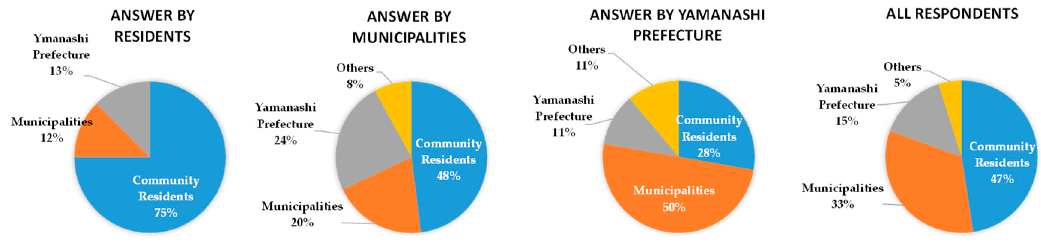
Figure 12. Distribution of responses by sectors on “Which stakeholder has the most important role in wide-area evacuation?”.